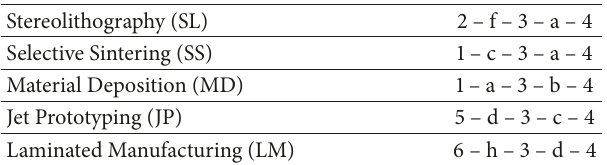
Table 10: Classification of the original processes in additive manu-